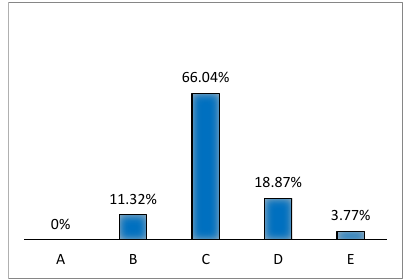
Figure 8. How difficult was the course? A: incomprehensible; B: too difficult; C: just right; D: too easy; E: